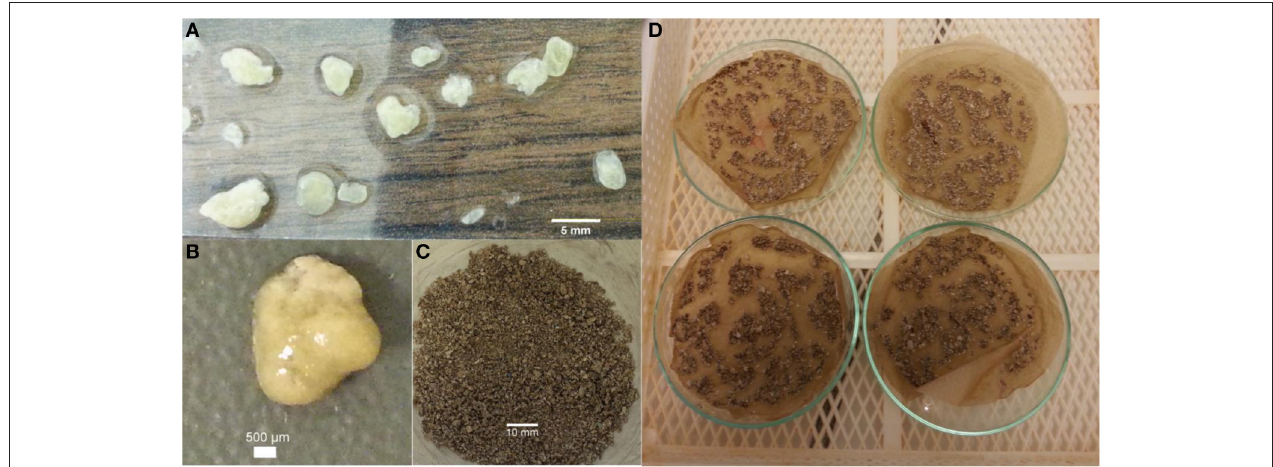
FIGURE 1 | Appearance of the harvested ACDC granules (A,B) wet; (C,D) after drying.